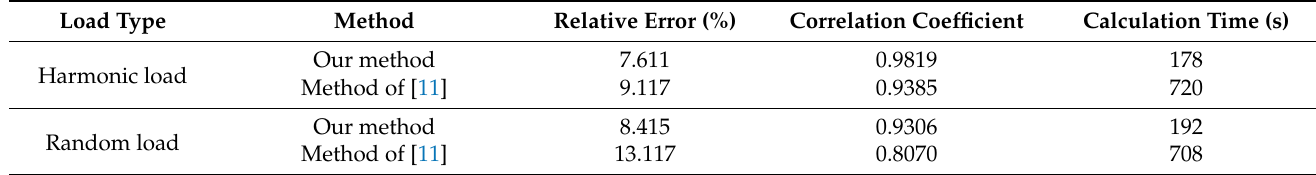
Table 5. Load identification results of both